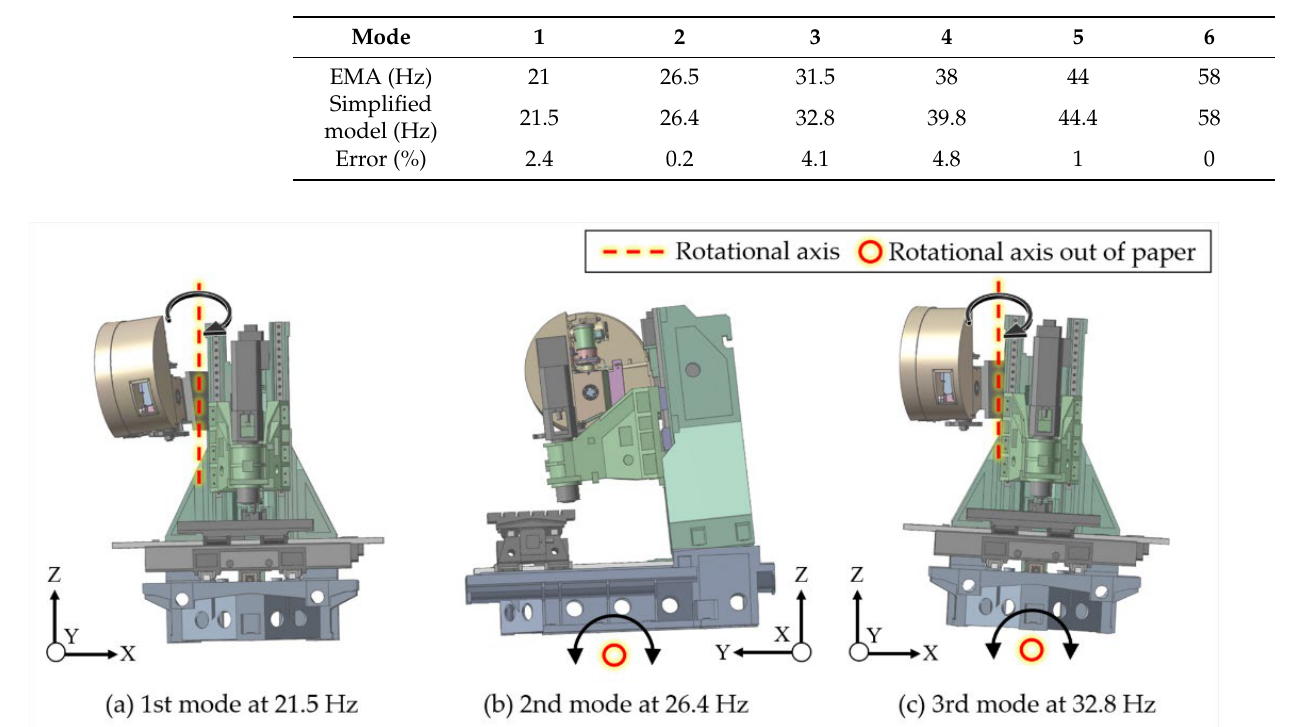
Table 5. Comparison of natural frequencies between experiment and simulation.